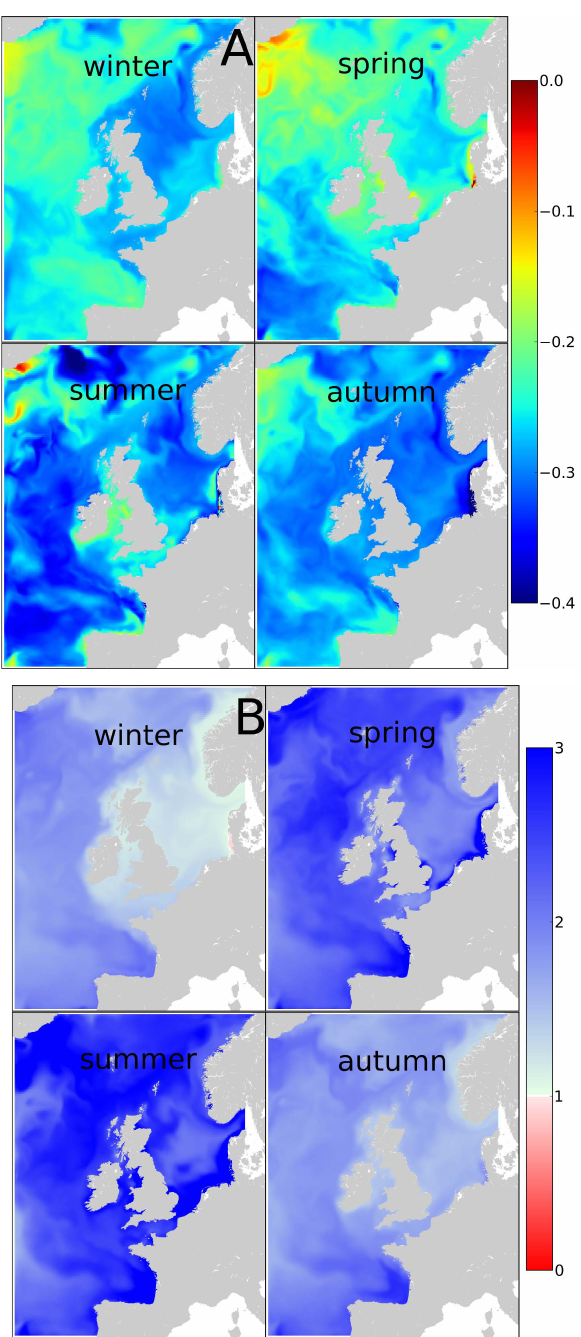
Fig. 2. Impacts of climate change and OA on the carbonate system as projected by the A1B scenario: (a) absolute difference in surface pH compared to the present-day scenario, and (b) future surface saturation state of